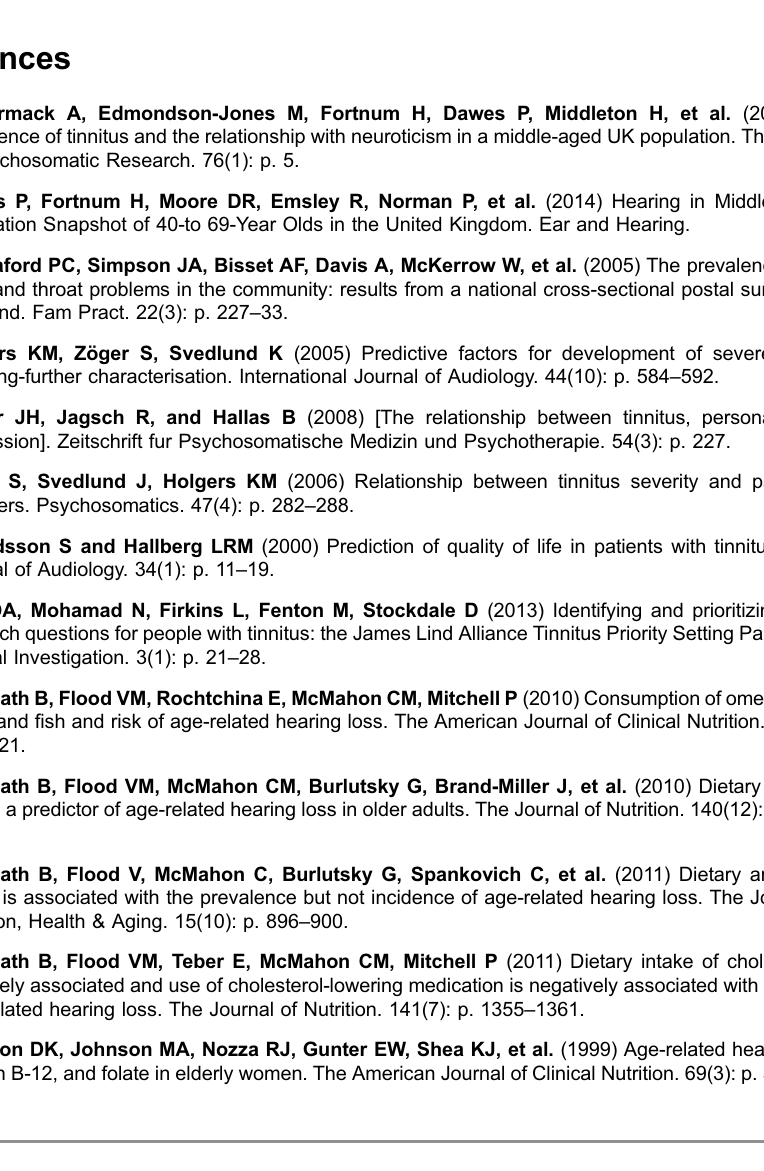
S1 Table. Dietary data in the UK Biobank